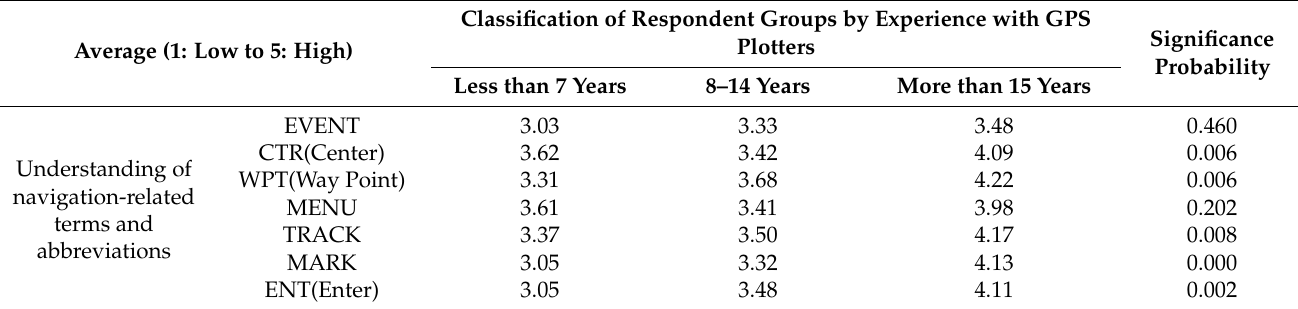
Table 6. Analysis of understanding of navigational terms according to user experience with GPS plotters. Classification of Respondent Groups by Experience with GPS Average (1: Low to 5: High)